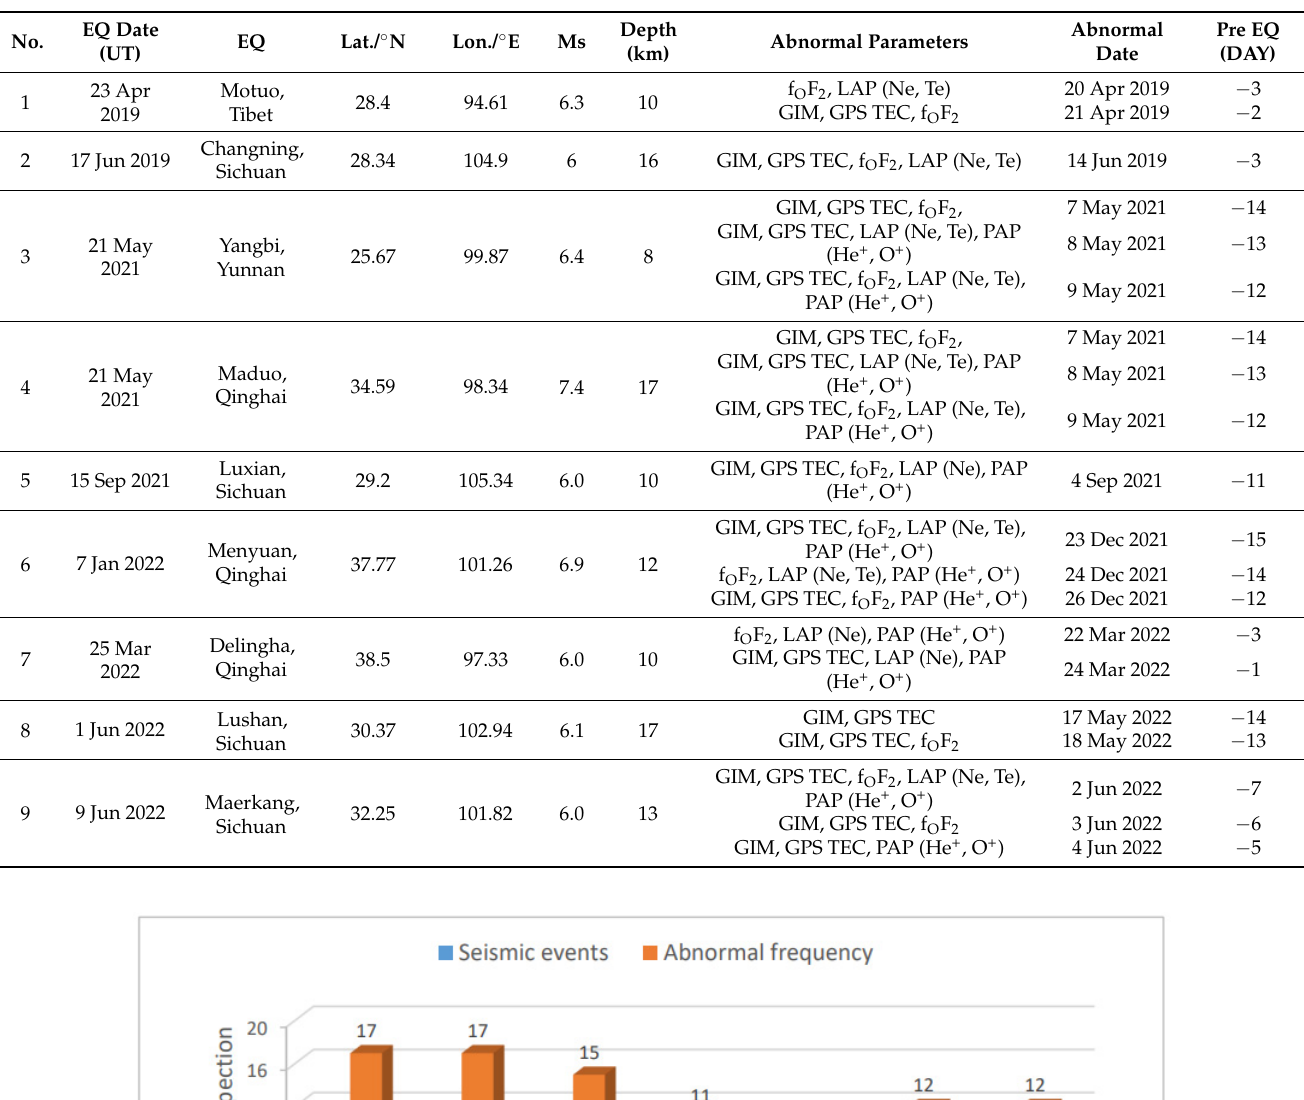
Table 2. Statistical table of seismo-ionospheric disturbances before nine earthquakes.